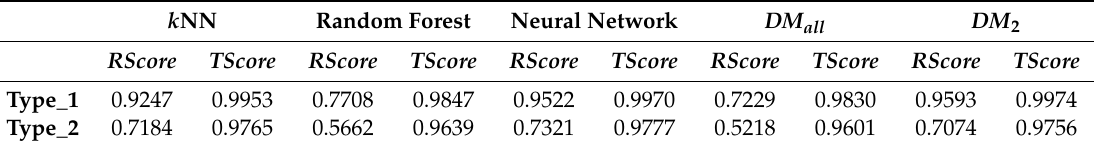
Table 7. The accuracy of the initial risk detection model for two types of test data. k NN